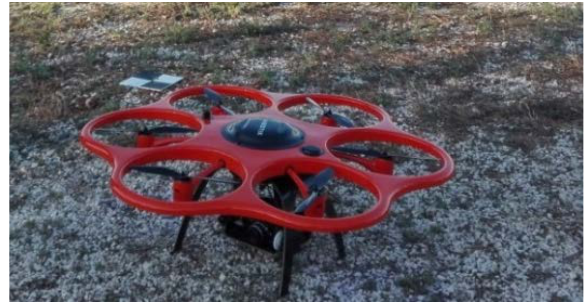
Figure 6. The hexacopter Aibot X6 V2 by Aibotix.